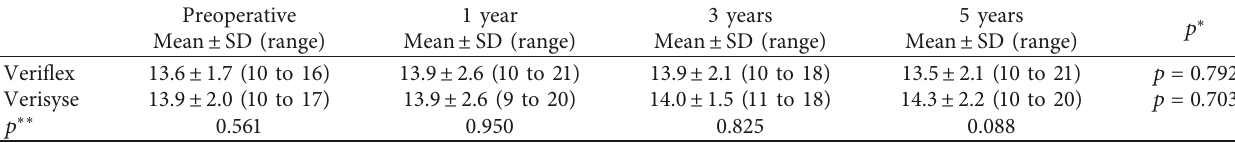
Table 5: Intraocular pressure during